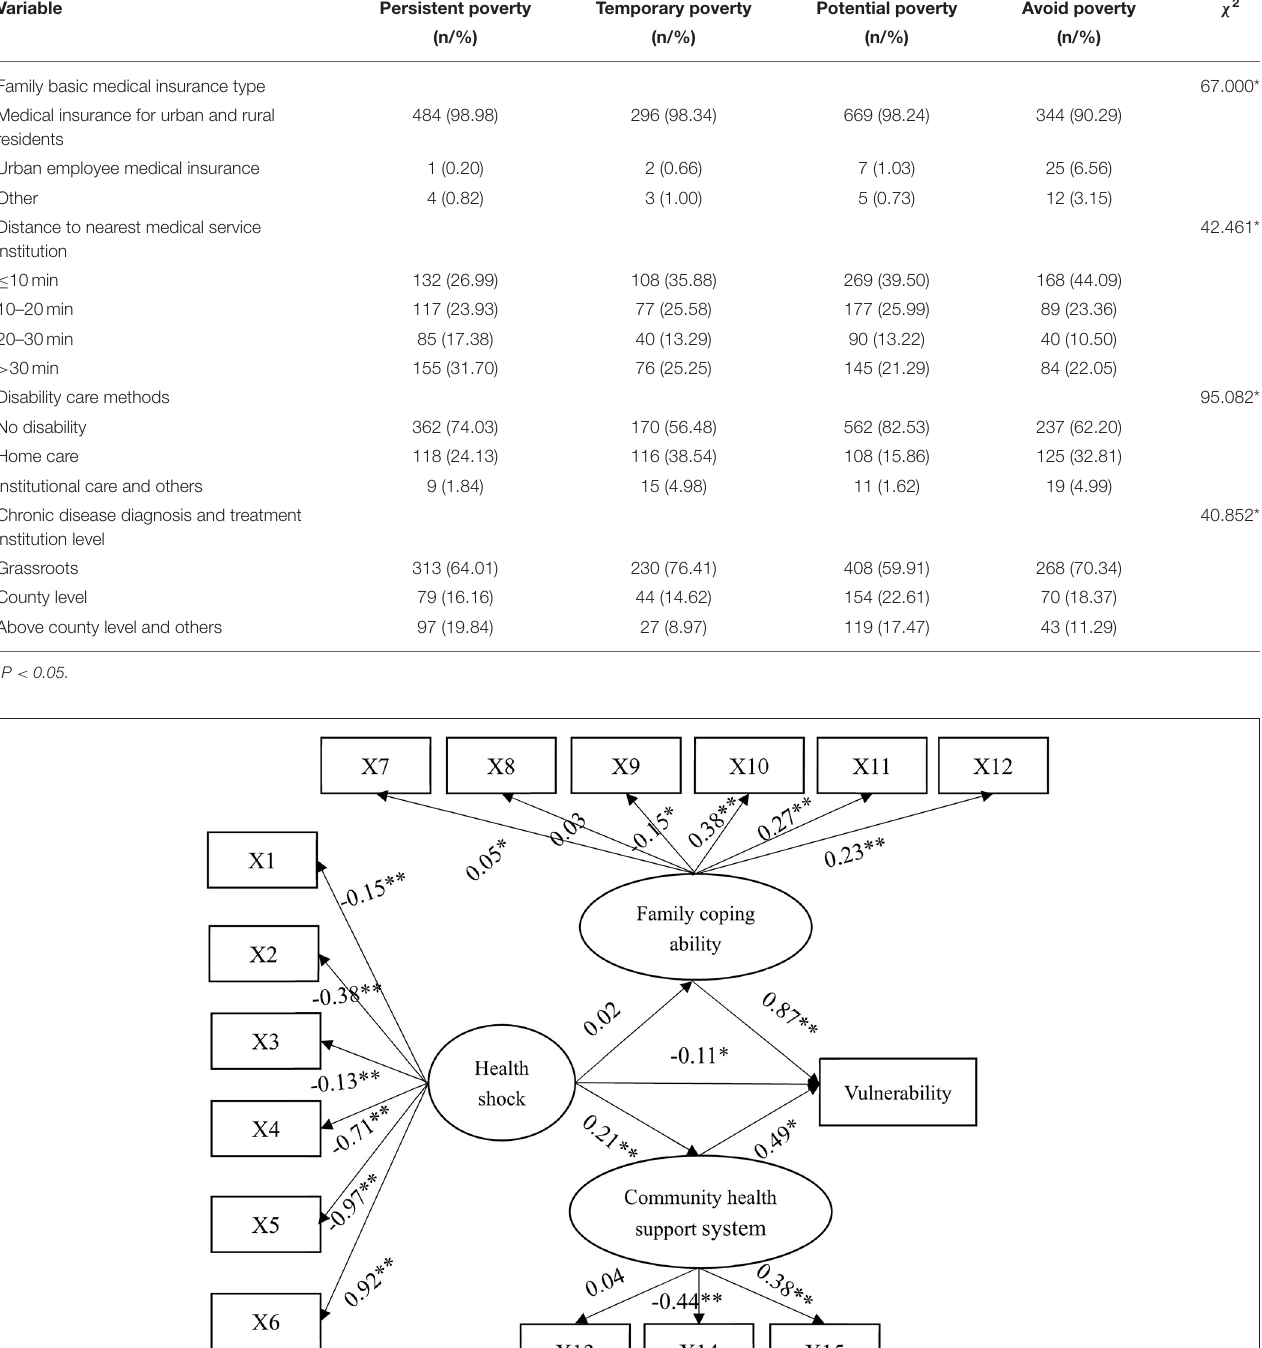
avoidance group can avoid the vulnerability of current and expected